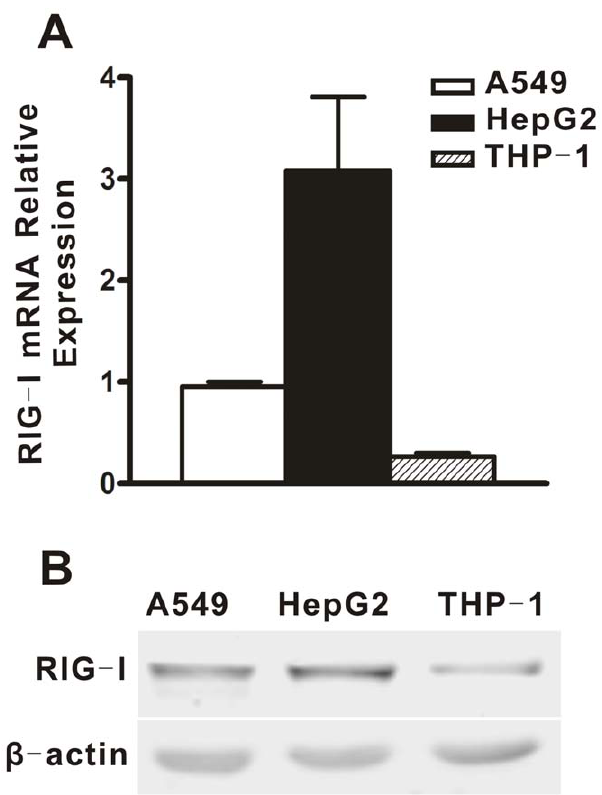
Figure 8. Expression of RIG-I in different cell lines. A549, HepG2 and THP-1 cells were harvested for real-time PCR analysis (A) or for Western blot analysis (B). Total cellular RNA was analyzed for RIG-I expression by real-time PCR and normalized to that of GAPDH in each sample. Data are shown as mean 6 SEM at least three independent